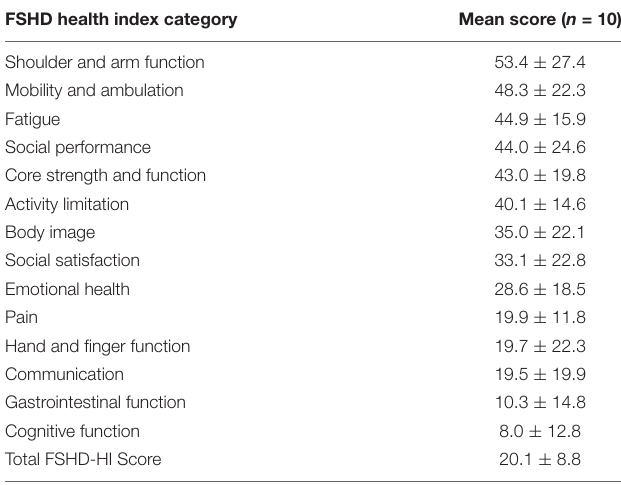
TABLE 3 | FSHD Health Index (HI) Survey mean